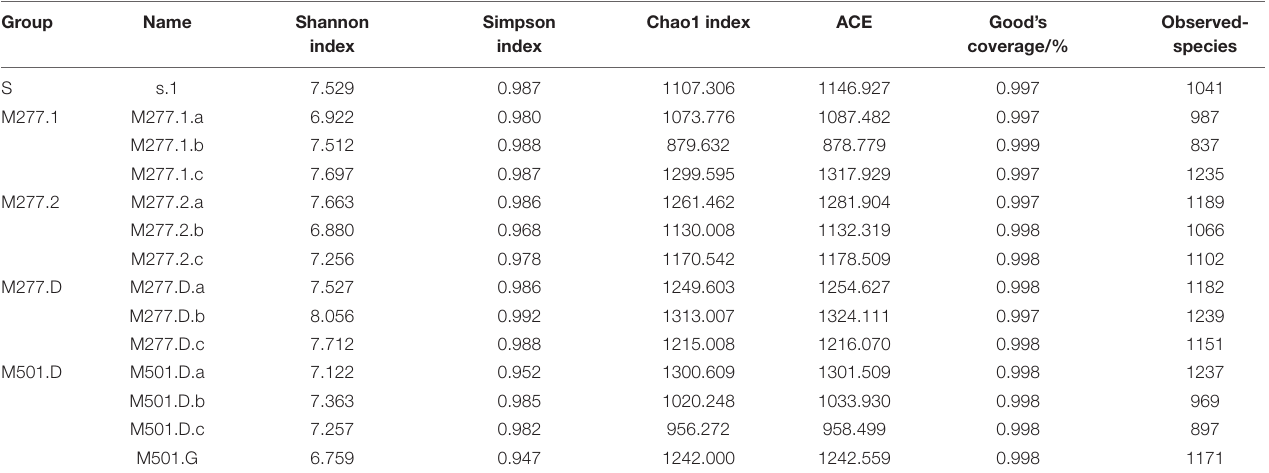
FIGURE 4 | Species abundance histogram at the genus level (TOP30). TABLE 2 | Alpha diversity index of soil